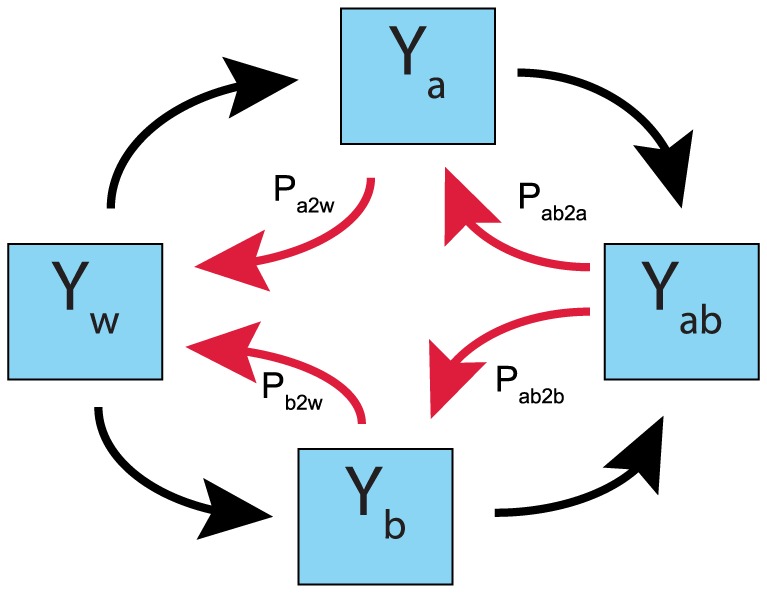
Schematic representation of a host population models that includes the possibility of resistance loss.A modified implementation of a previous host population model [40] under a combination of two drugs a and b (Equation S6 and S7 in File S1) takes into account the possibility of resistance loss. Hosts can be infected by pathogens of four different types: wild type, a-resistant, b-resistant and a,b-resistant. The numbers of individuals infected are correspondingly represented by variables yw, ya, yb, and ya,b. The original model [40] considered only the possibility of acquiring resistance (black arrows). In our modified host population model, motivated by our findings in the single host model, we assume that a nonzero resistance-decaying rate can cause loss of resistance (red arrows).